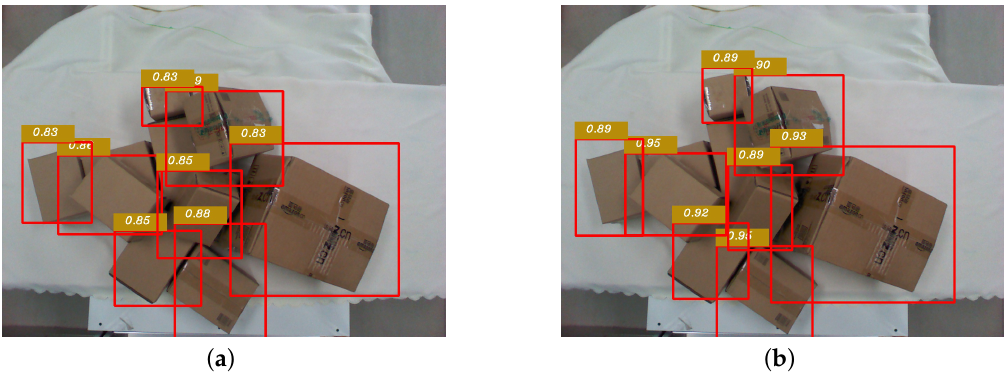
Figure 11. Comparison before and after adding the batch normalization (BN)–rectified linear unit (RELU)–convolution layer (Conv) module. ( a ) Without the BN-RELU-Conv module. ( b ) With the BN-RELU-Conv